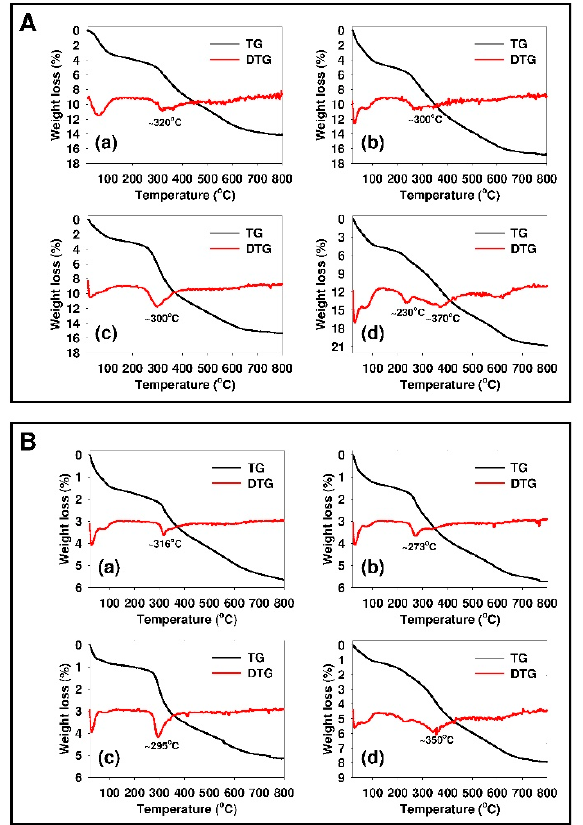
Figure 3. Thermogravimetric analysis of ( A ) functionalized SBA-15: ( a ) SBA-15-AP, ( b ) SBA-15-MAP, ( c ) SBA-15-DMAP, ( d ) SBA-15-AEAP, and ( B ) functionalized Aerosil ® : ( a ) Aer-15-AP, ( b ) Aer-15-MAP, ( c ) Aer-15-DMAP, and ( d ) Aer-AEAP.